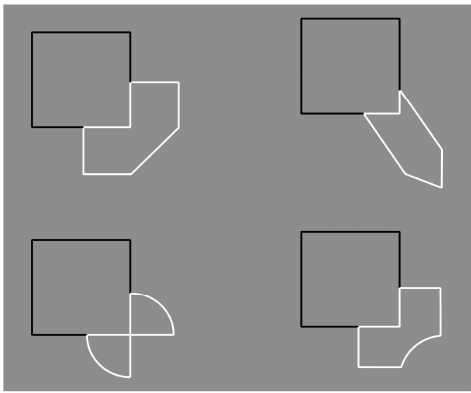
Figure 20. The contrast polarity reverses the amodal completion: The square is now perceived as partially occluded by the asymmetrical objects (for a control see Figure 21).